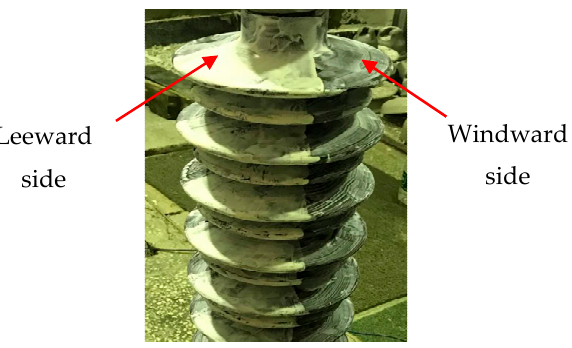
Figure 12. Schematic diagram of staining in the tests.